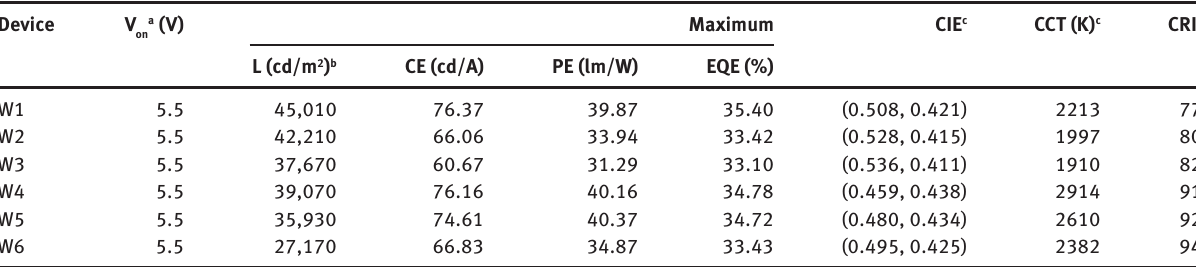
Table 3: The EL performance parameters summary of three- and four-color tandem white devices W1–W6.